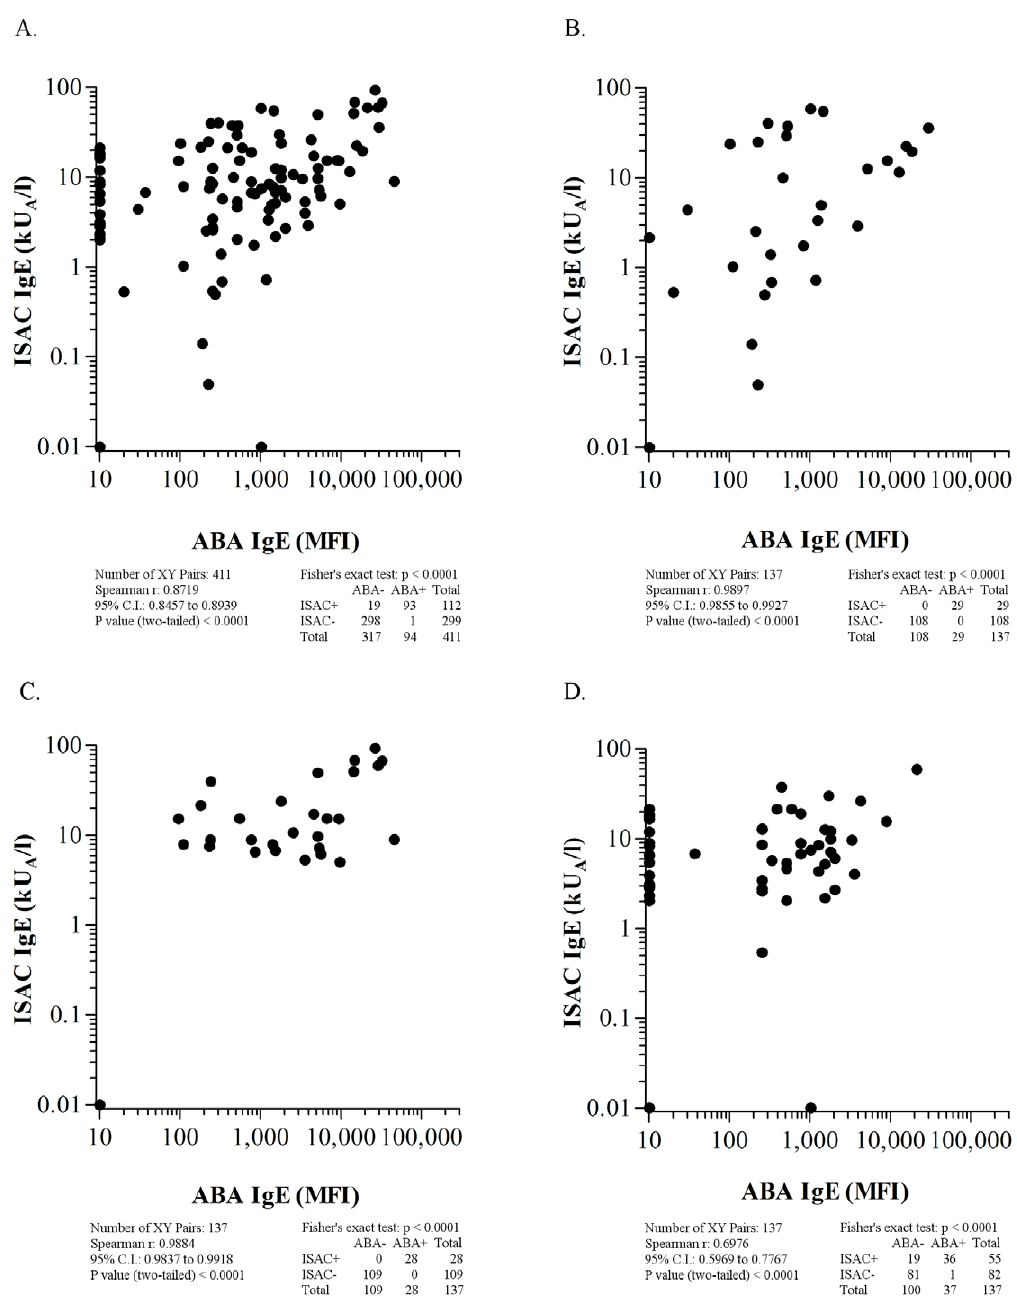
Figure 4. ABA versus ISAC correlation results on 137 serum samples selected on the basis of nDer s 1, nPen m 1, and nPru p 3 mutually exclusive IgE positivity are reported. Panel A: All 411 IgE values, obtained by testing the three allergens; Panel B: 137 IgE results obtained on nDer s 1 allergen; Panel C: 137 IgE results obtained on nPen m 1 allergen; Panel D: 137 IgE results obtained on nPru p 3 allergen. For graphical visualization needs on log scales, zero values for ABA were set at 10 MFI on the X axis, and at 0.01 kU/l for ISAC values on the Y axis. The Spearman r correlation coefficient, the x 2 and the Fisher’s exact tests were used where applicable.